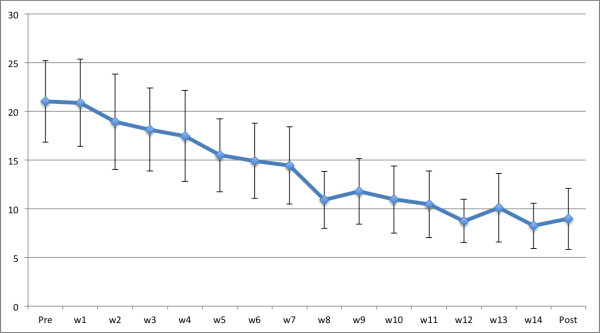
Means and 95% confidence intervals of weekly OCD symptoms using OCI-R.